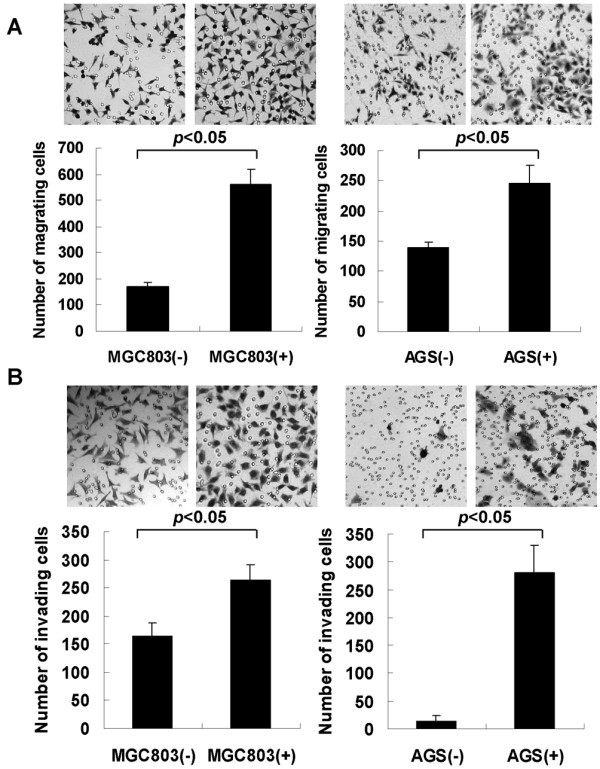
Mycoplasma hyorhinis promotes migration and invasion. 2 × 104-1 × 105 cells were cultured in the top chamber of Transwell for 24-36 hours. After removing the cells on the top with a cotton swab, the cells attached on the bottom side of the membrane were fixed by methanol, stained with 5% crystal violet. The number of cells was counted. The graphs were the composite results from three independent experiments. A. Migration of uninfected cells (-) or infected cells (+). B. Invasion of uninfected cells (-) or infected cells (+). The number of migration cells and invasion cells of infected group were higher than those of uninfected group (P < 0.05).